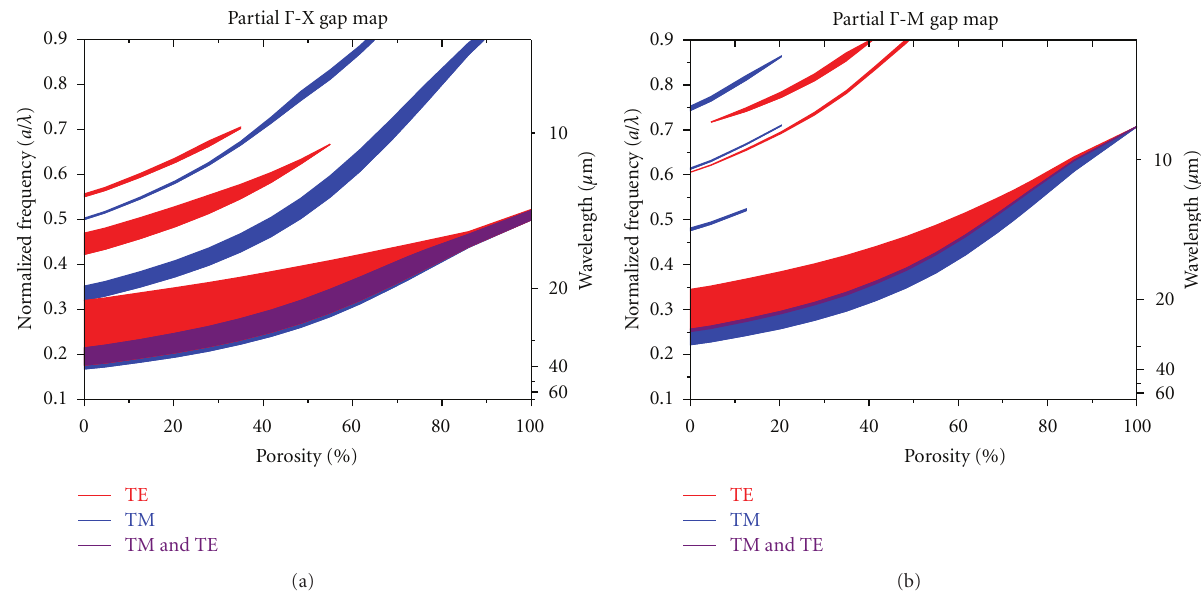
Figure 5: (a) Partial Γ -X gap map as a function of the PSi layer porosity. On the right y axis, equivalent wavelength is indicated for a lattice parameter a = 7 μ m. (b) Partial Γ -M gap map as a function of the PSi layer porosity. The wavelength on right y axis is indicated for a lattice parameter a = 7 μ m, as the experimental one.